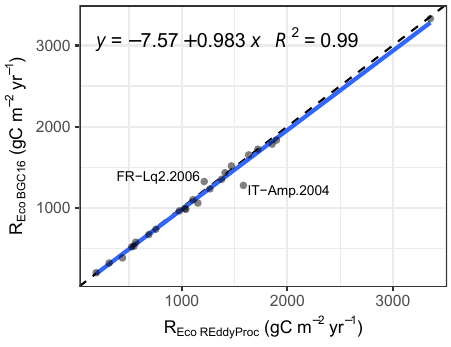
Figure 6. Predictions of annually aggregated ecosystem respiration, R eco , from REddyProc nighttime partitioning agree with the pre- dictions by